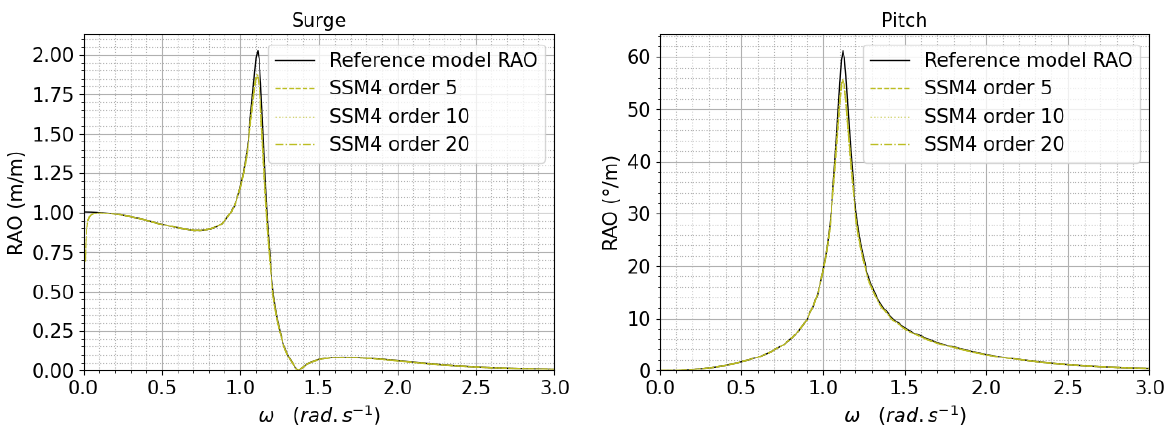
Figure 12. Comparison between SSM4 and the reference RAO for surge and pitch motions.